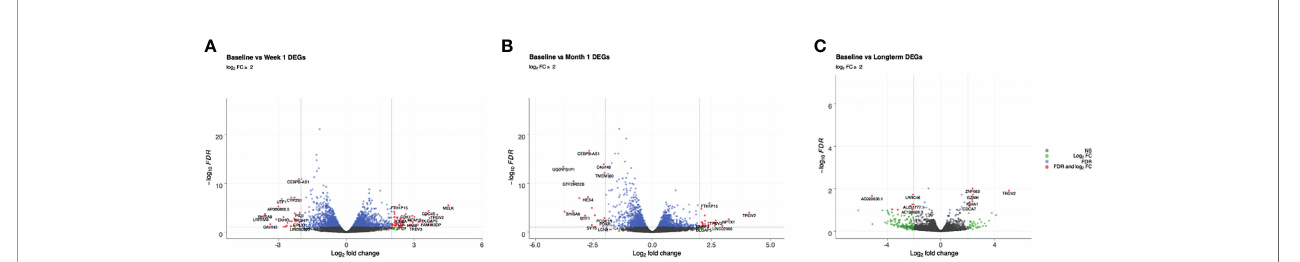
FIGURE 1 | Volcano plots of genes that are differentially expressed between (A) baseline and week 1; (B) baseline and month 1; (C) baseline and long-term in patients that developed DNAemia. Gray points represent genes that are not differentially expressed, green points represent genes that have a log 2 FC ≥ 2 but not differentially expressed, blue points represent genes that are differentially expressed (FDR ≤ 0.1) but have a log 2 FC < 2, and red points represent genes that are both differentially expressed (FDR ≤ 0.1) and have a log 2 FC ≥